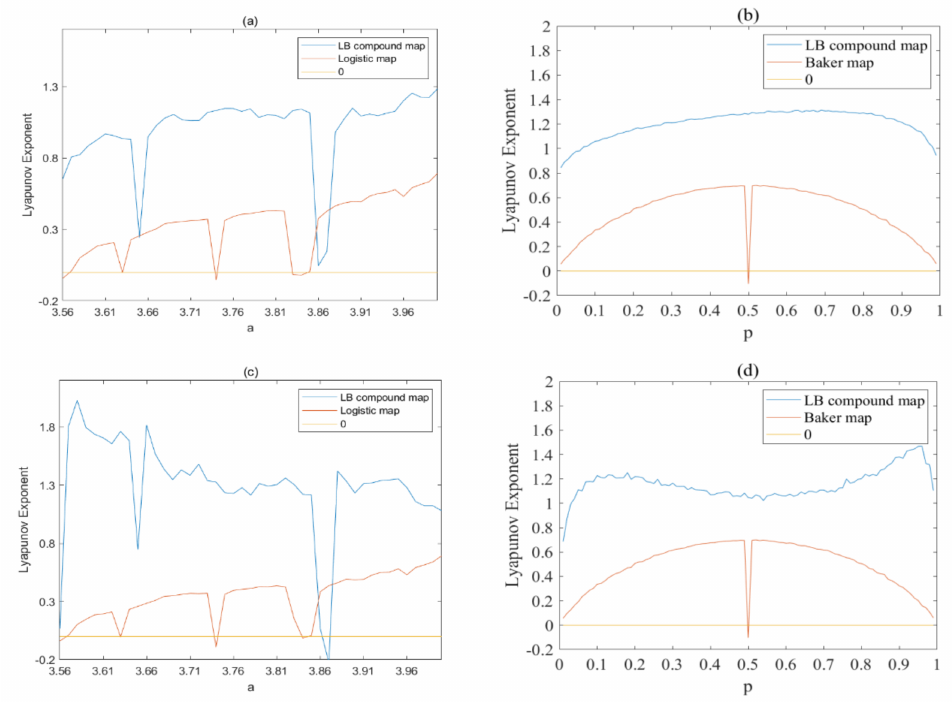
Figure 8. Lyapunov exponent analysis of the LB compound chaotic map: ( a , b ) x-dimensional variable; ( c , d ) y-dimensional